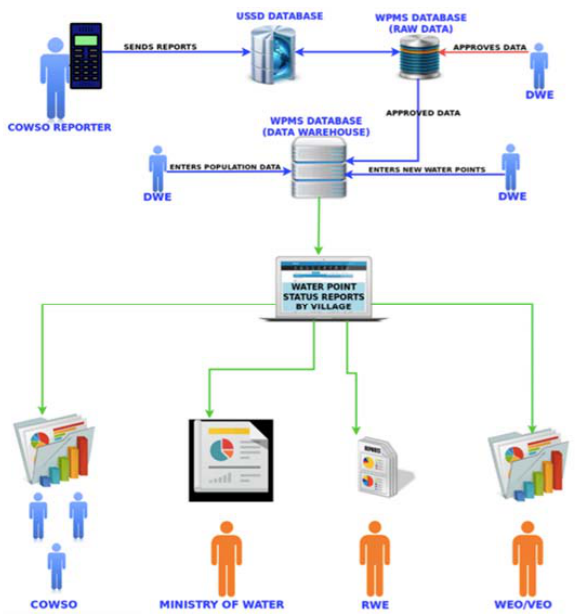
Figure 6. The Mobile reporting system showing the flow of information.